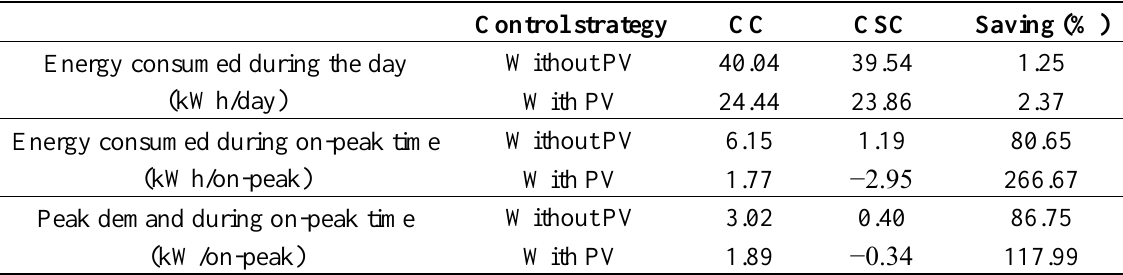
Table 6. Comparison of electricity consumption and peak demand for two test days using conventional and peak reduction control strategies in space-cooling-mode tests (CSC in space cooling